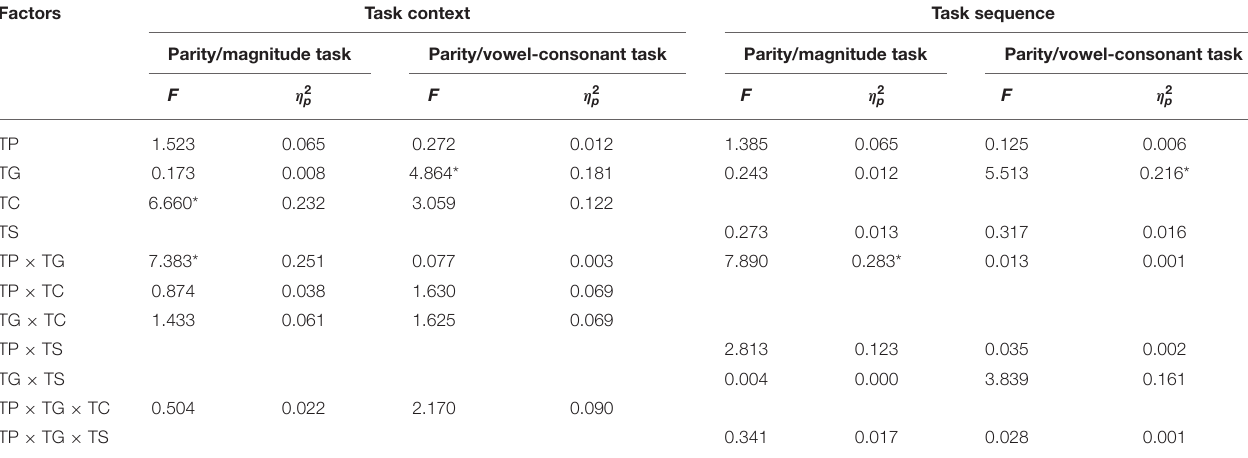
TABLE 5 | Significance statistics of switch cost in parity/magnitude and parity/vowel-consonant tasks. Factors Task context Task sequence Parity/magnitude task Parity/vowel-consonant task Parity/magnitude task Parity/vowel-consonant